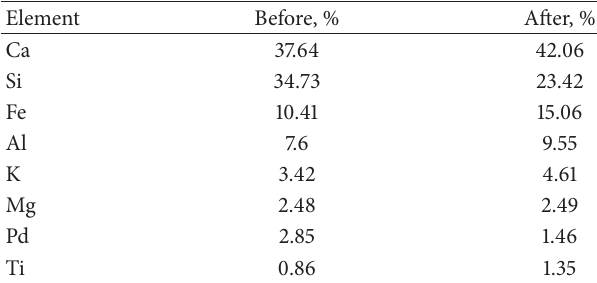
Table 12: Values of constituent soil elements, before and after